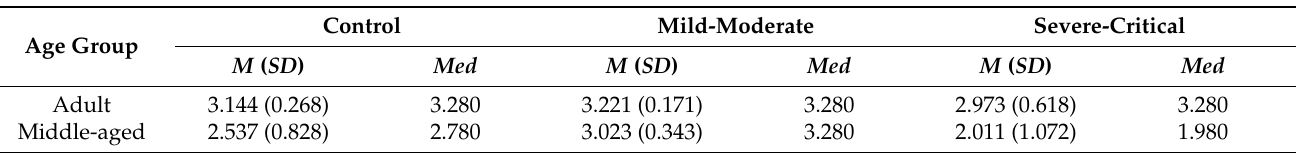
Table 3. Values of d’ for 2AFC phase 1 by